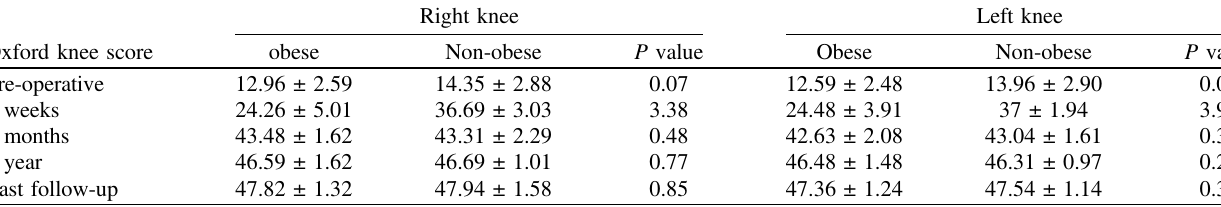
Table 3. Comparison of the Oxford Knee Score between the two groups.